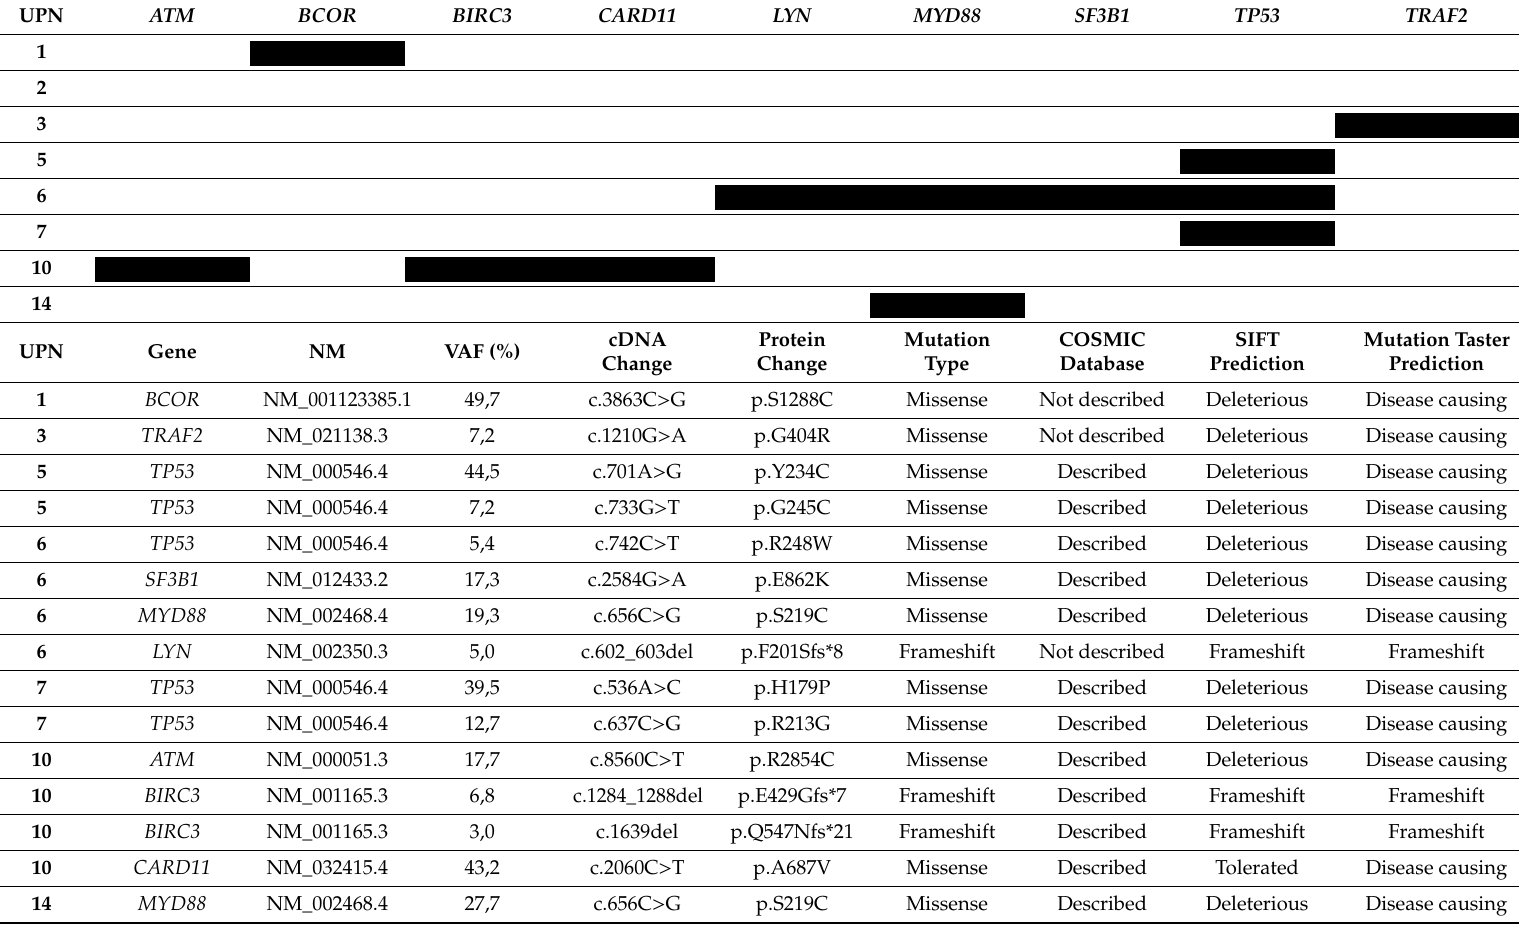
Table 2. Mutational landscape of eight patients. Overview (top) and details (down) of results of the molecular analysis of eight patients. UPN: Unique patient number; VAF: Variant allele